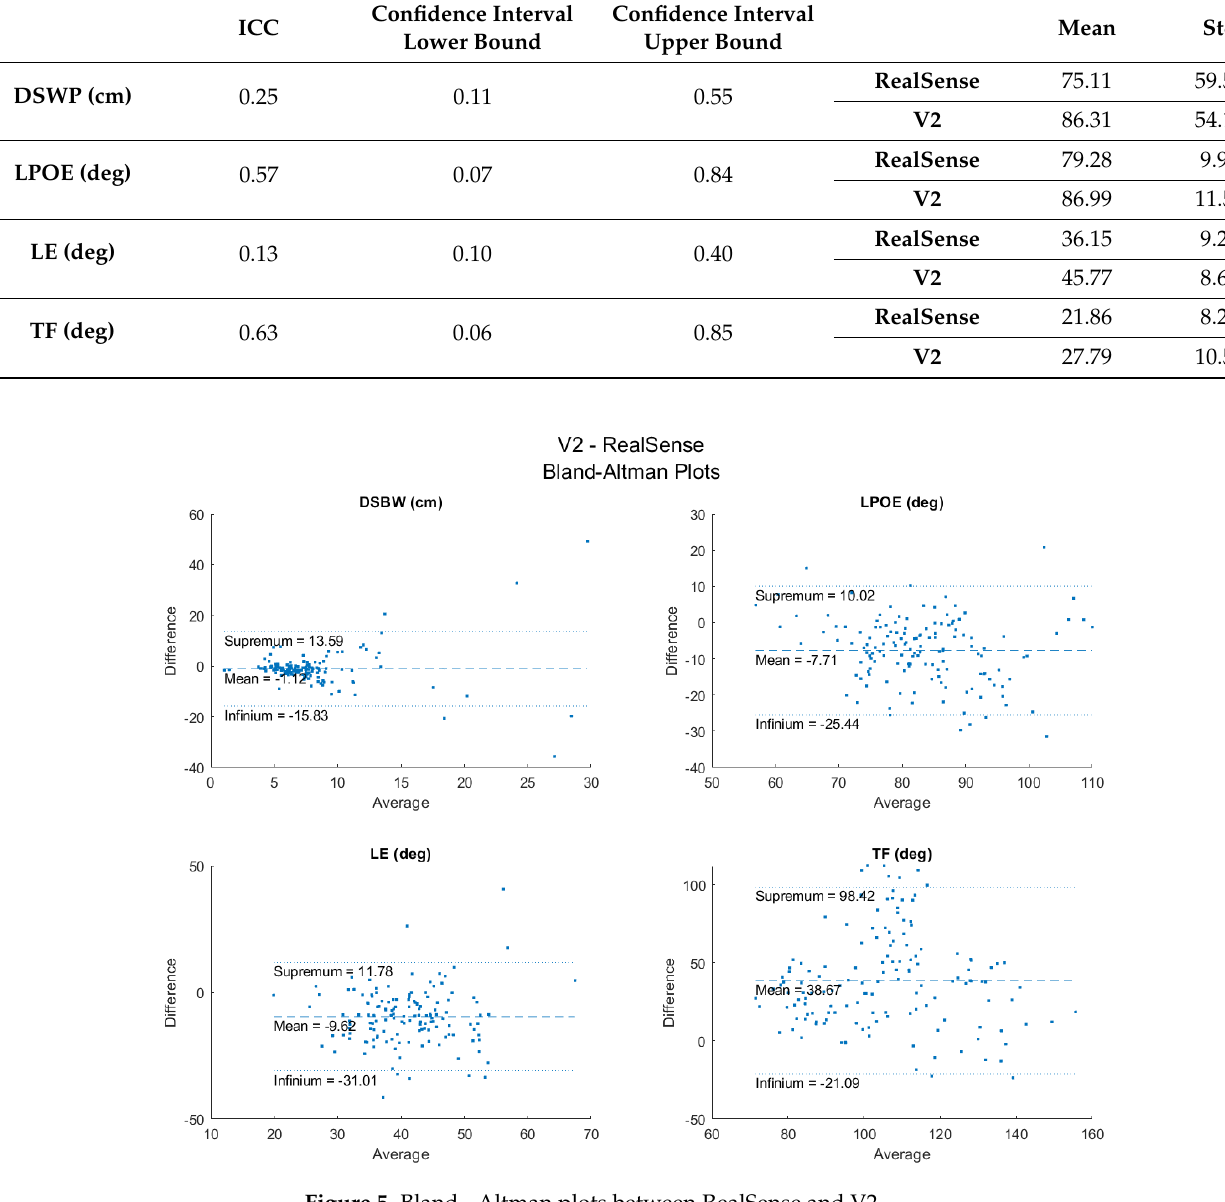
Figure 5. Bland − Altman plots between RealSense and V2.